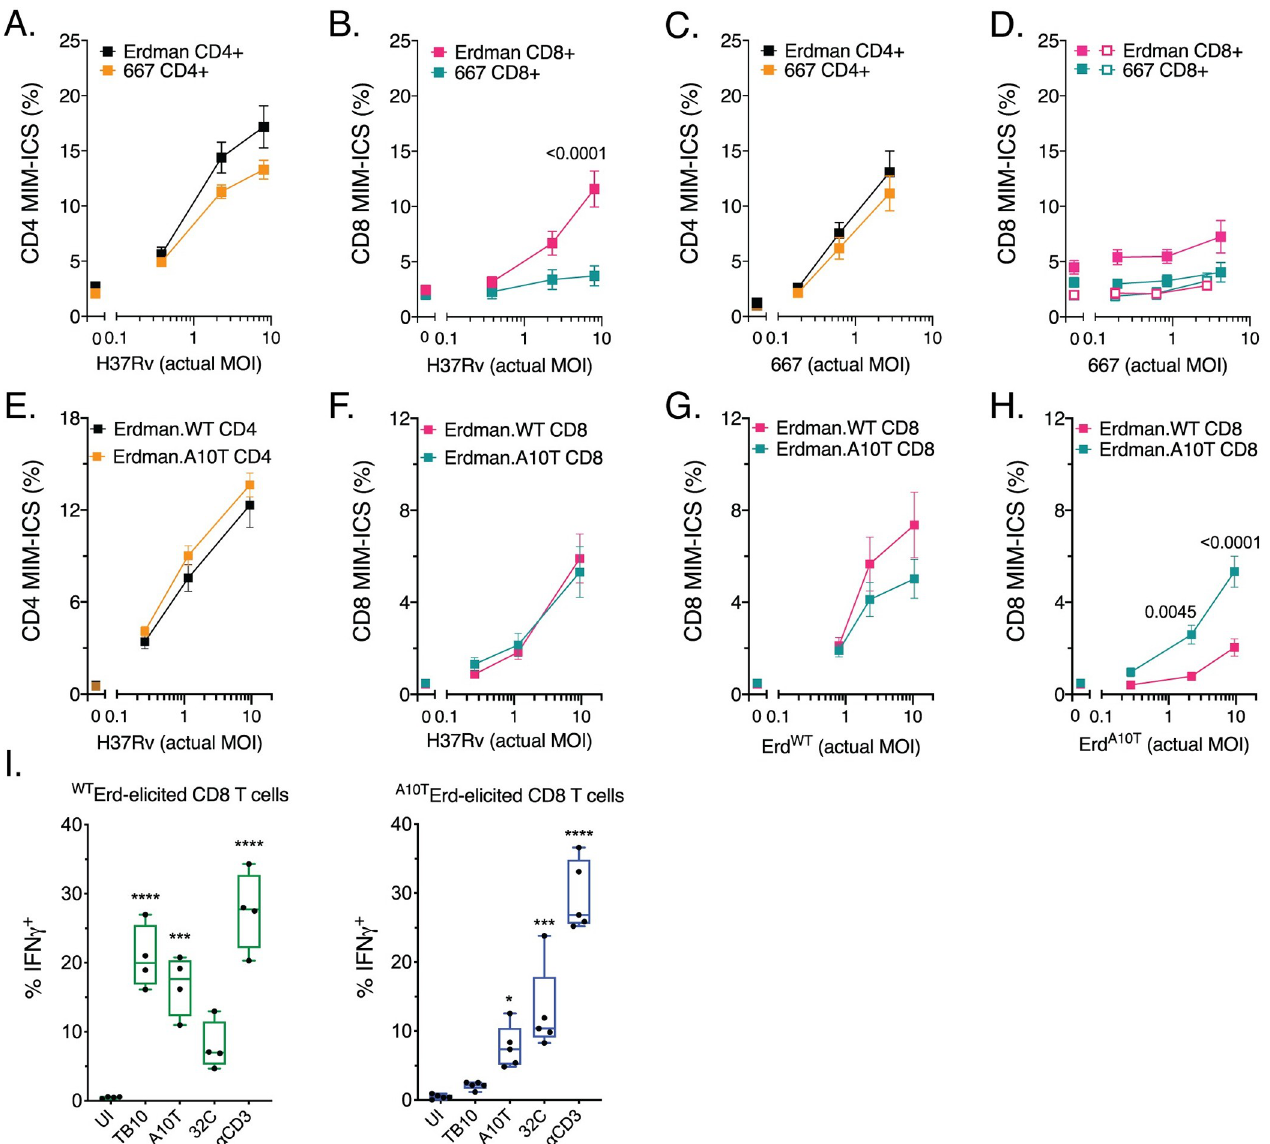
Fig 5. T cell recognition of infected macrophages. CD4 (A, C) or CD8 T cells (B, D) purified from the lungs of Erdman- or 667-infected mice were cultured with H37Rv-infected (A, B) or 667-infected (C, D) macrophages and the MIM-ICS assay was performed. MIM-ICS assay of isogenic strains elicited (E) CD4 T cells and (F) CD8 T cells in recognizing H37Rv-infected macrophages. Isogenic strains elicited CD8 T cells were also measured for their recognition ability of (G) Erd.EsxH WT -infected and (H) Erd.EsxH A10T -infected macrophages. The X axis is the actual multiplicity of infection (MOI) as determined by CFU plating. Statistical significance was determined by multiple t testing, and p values < 0.05 are shown above the bars. (I) Erd.EsxH WT - or Erd.EsxH A10T -elicited CD8 T cells were cultured with uninfected macrophages (UI) or macrophages plus the indicated peptide epitopes or anti-CD3 mAb. Statistical significance was determined by one-way Anova, and p values < 0.05 are shown above the bars. Results are representative of two (A-H) or three (I) different independent experiments. All four T cell lines recognized the two TB10 epitopes with a similar hierarchy: TB10RgP ~ TB10Rg3 > TB10RgR > TB10RgL (Fig 6C). While TB10RgP, TB10Rg3, and TB10RgR all rec- ognized the WT and A10T epitopes similarly, TB10RgL only recognized the A10T epitope with low avidity. Importantly, the TCRs used by TB10RgR and TB10RgL differ by two amino acids–one in the CDR3 α region and one in the CDR3 β region [13]. As both of these T cells